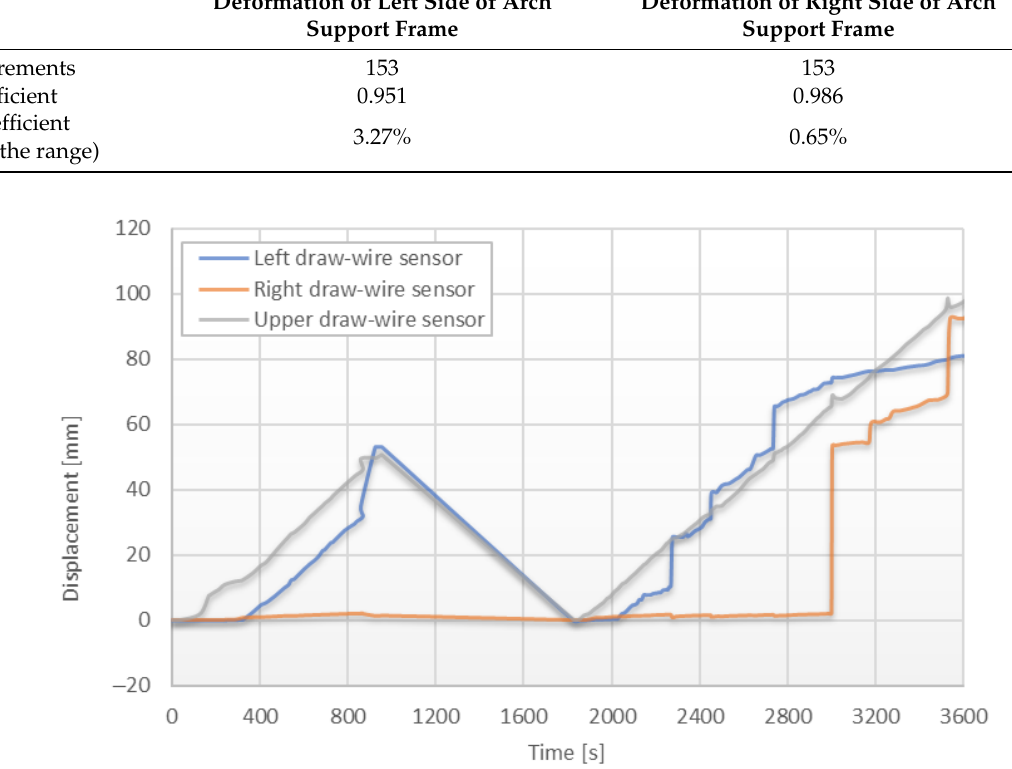
Table 5. Bland Altman and Spearman correlation coefficient of the values of deformation by differ- ent methods.